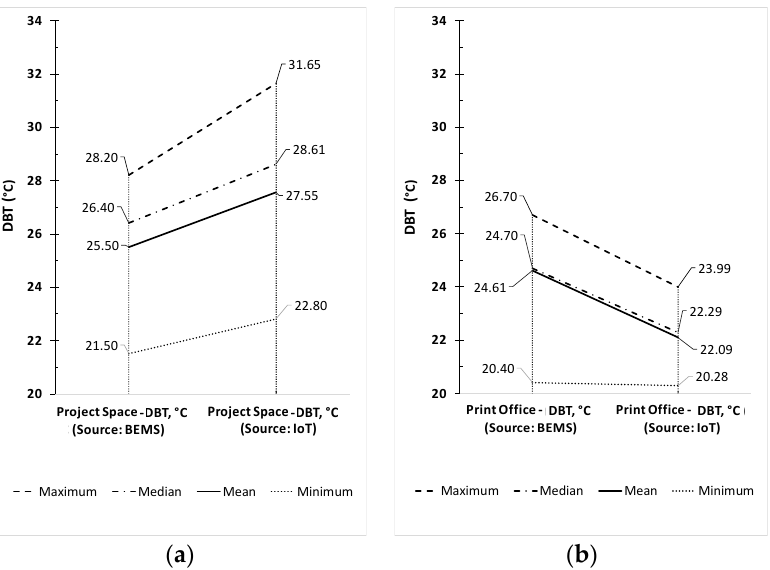
Figure 8. Validation and Deviations between IoT and BEMS data in ( a ) Project Space in March 2019 and ( b ) Print Office in April 2019.